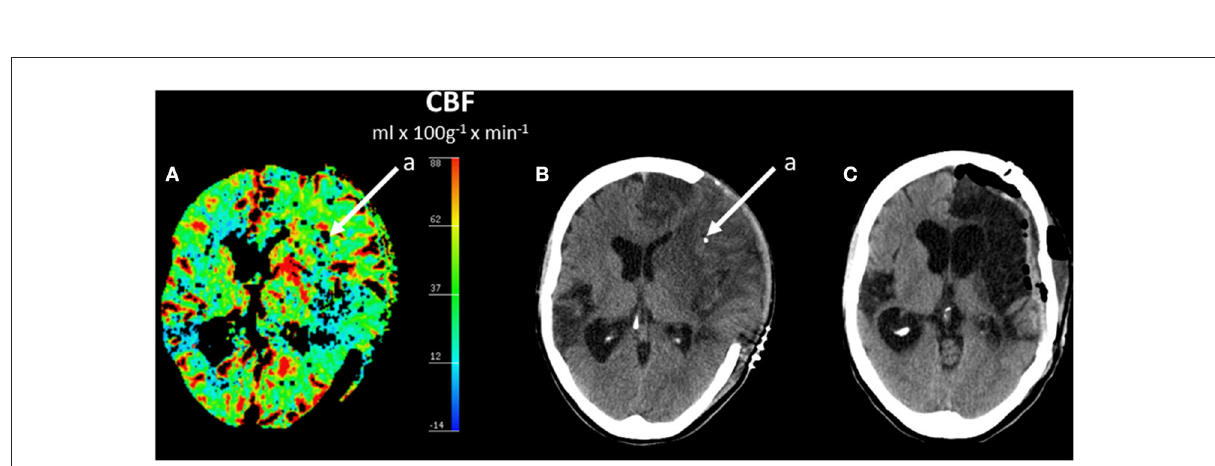
FIGURE6 Regional cerebral blood flow (CBF) after hemicraniectomy in a patient with malignant brain edema after middle cerebral artery (MCA) infarct (A) and corresponding acute CT scan (B) and CT scan after 6 months (C) . (A,B) Shows the position of one intracerebral microdialysis catheter (a) in the infarcted hemisphere. (C) Shows the CT scan 6 months later after replacement of the skull bone. Data from (89).